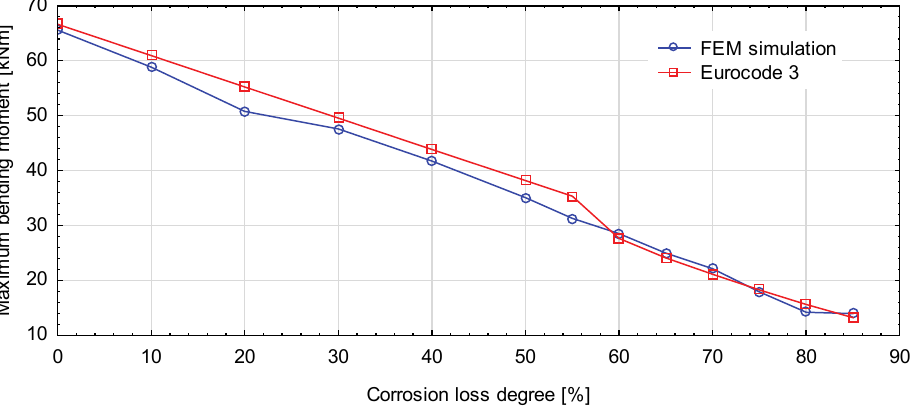
Fig. 8. Maximum bending moment from FEM simulation and Eurocode analysis by degree of corrosion loss 180  140